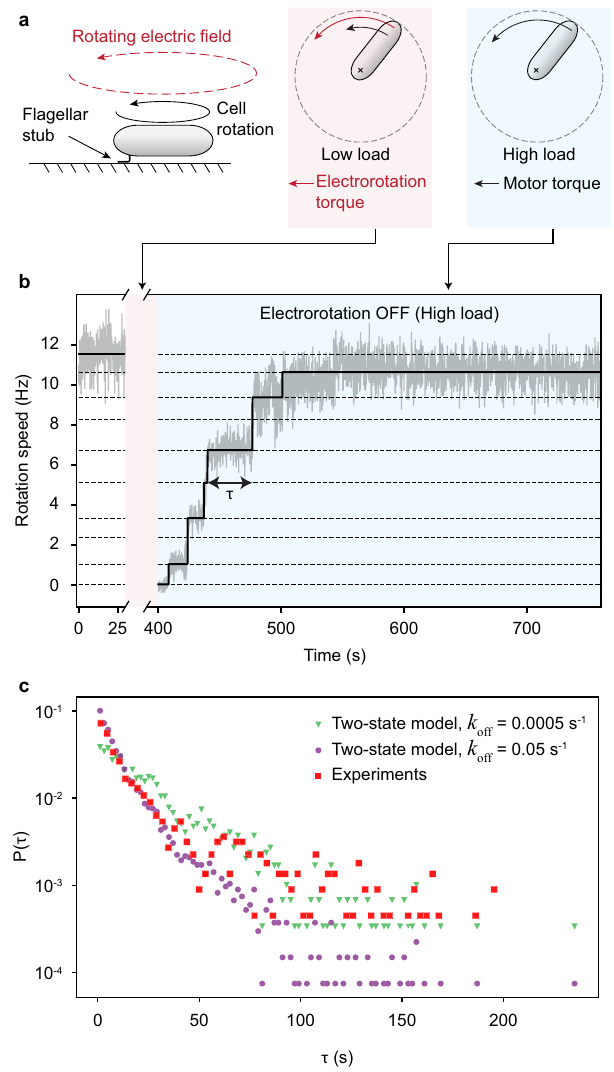
Fig. 1 | Single-motor electrorotation experiments. a Experimental strategy. The cellistetheredtoasurfaceviaashort fl agellarstub(left).Ahigh-frequencyrotating electric fi eld then applies an external torque (red) on the cell, which decreases the motorload(middle).Underlowload,themotorreleasesitsboundstatorunits.The electrorotationtorqueisthenswitchedOFF,whichincreasestheloadonthemotor (right).Inresponse,themotorrecruitsstatorunits,leadingtostepwiseincreasesin rotation speed. b Motor speed (gray) as a function of time in an electrorotation experiment, showing fi tted steps (black). The dashed lines indicate the discrete speed levels. c Distribution of the dwell times τ from the electrorotation experi- ments (red squares), as well as from simulations of two different scenarios of the two-state model ( k off = 0.0005 s − 1 , green triangles; k off = 0.05 s − 1 , purple disks). Bin size d τ = 3